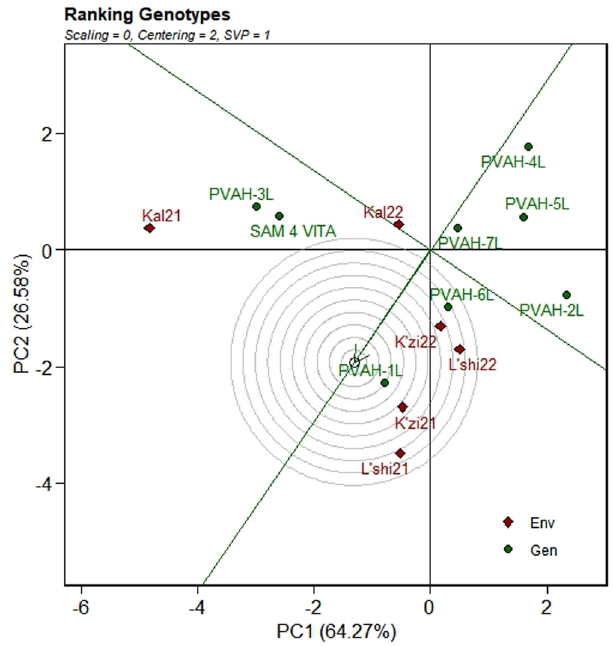
Figure 3: Ranking of eight provitamin A maize relative to an ideal